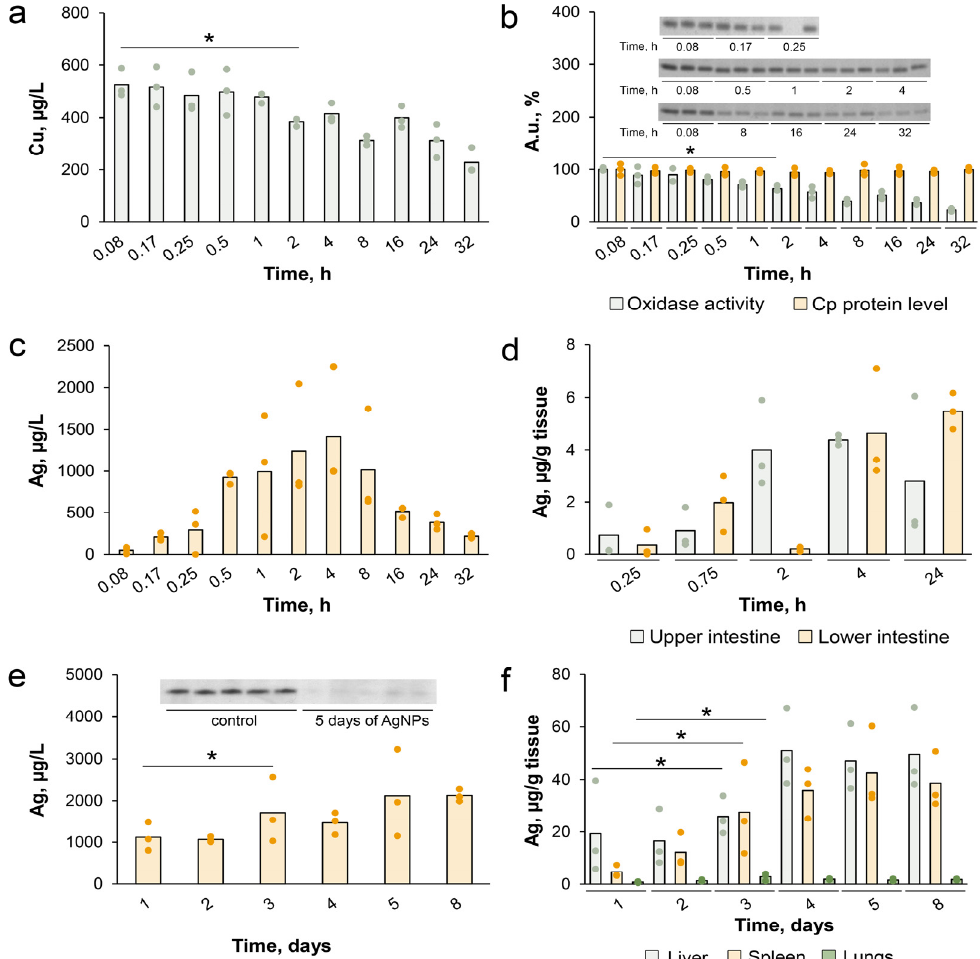
Figure 3. Dynamics of silver and copper distribution in blood serum and liver tissue of mice treated with a single AgNPs injection. ( a ) Concentration of copper in blood serum; ( b ) Serum oxidase activity (green points; sample pictures of in-gel assessment of oxidase activity, which was used to build the bar chart are given above the chart), and Cp protein concentration in the same samples (orange points); ( c ) Concentration of silver in blood serum; ( d ) Silver excretion through the intestine; Dynamics of silver accumulation in ( e ) blood serum and ( f ) organ tissues during 8 days of daily AgNPs injections. The data are presented as mean value (bar) and individual experimental samples (points), n = 3. * p < 0.05.